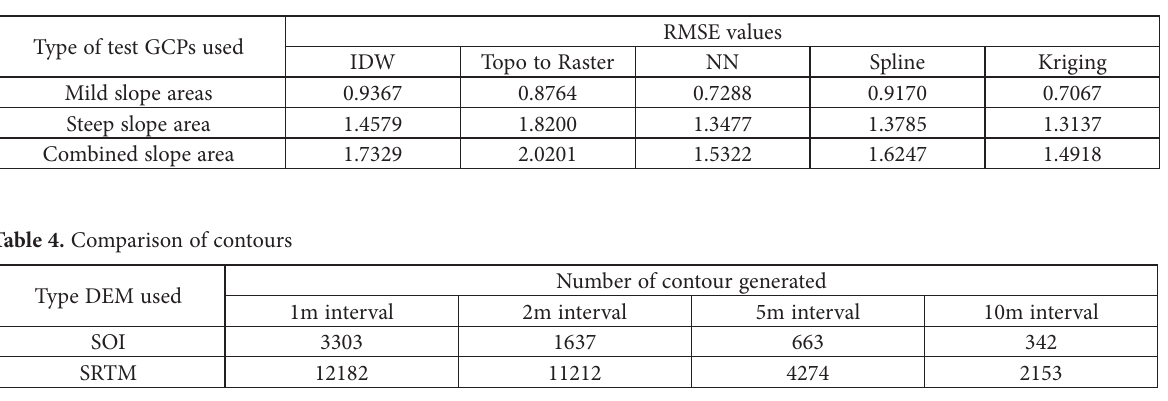
Table 3. RMSE values with reference to terrain variation Type of test GCPs used